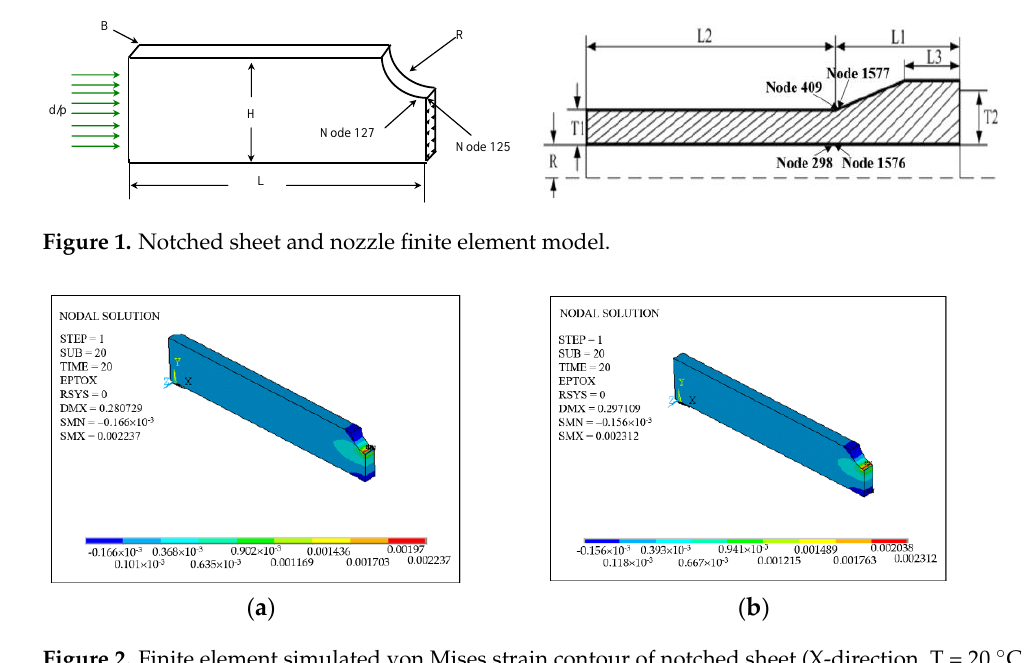
Figure 2. Finite element simulated von Mises strain contour of notched sheet (X-direction, T = 20 °C, b = 20 mm, r = 25 mm, ratio = −1). ( a ) Elastic analysis; ( b ) elastoplastic analysis.